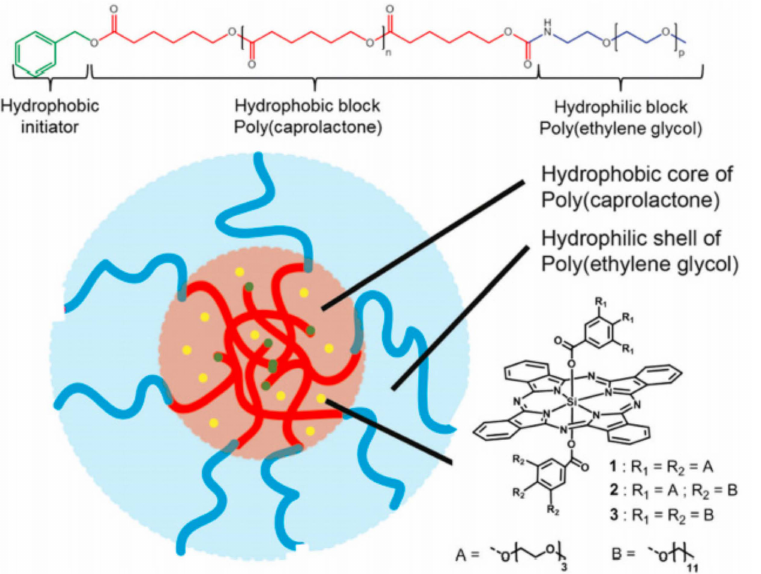
Scheme 8. Schematic representation of the PEG- b -PCL based micelles as carriers for a series of new third generation PS based on SiPc (compounds 1 and 2 , while 3 serves as a reference lipophilic derivative) in PCL–PEG polymeric micelles. Reprinted with permission from ref [40].